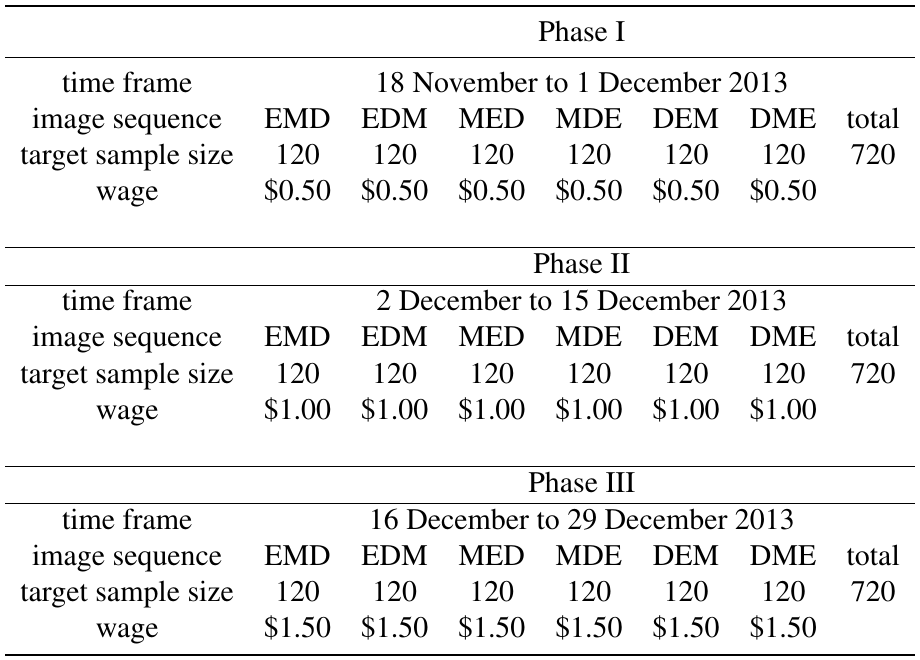
Table 1. Experimental